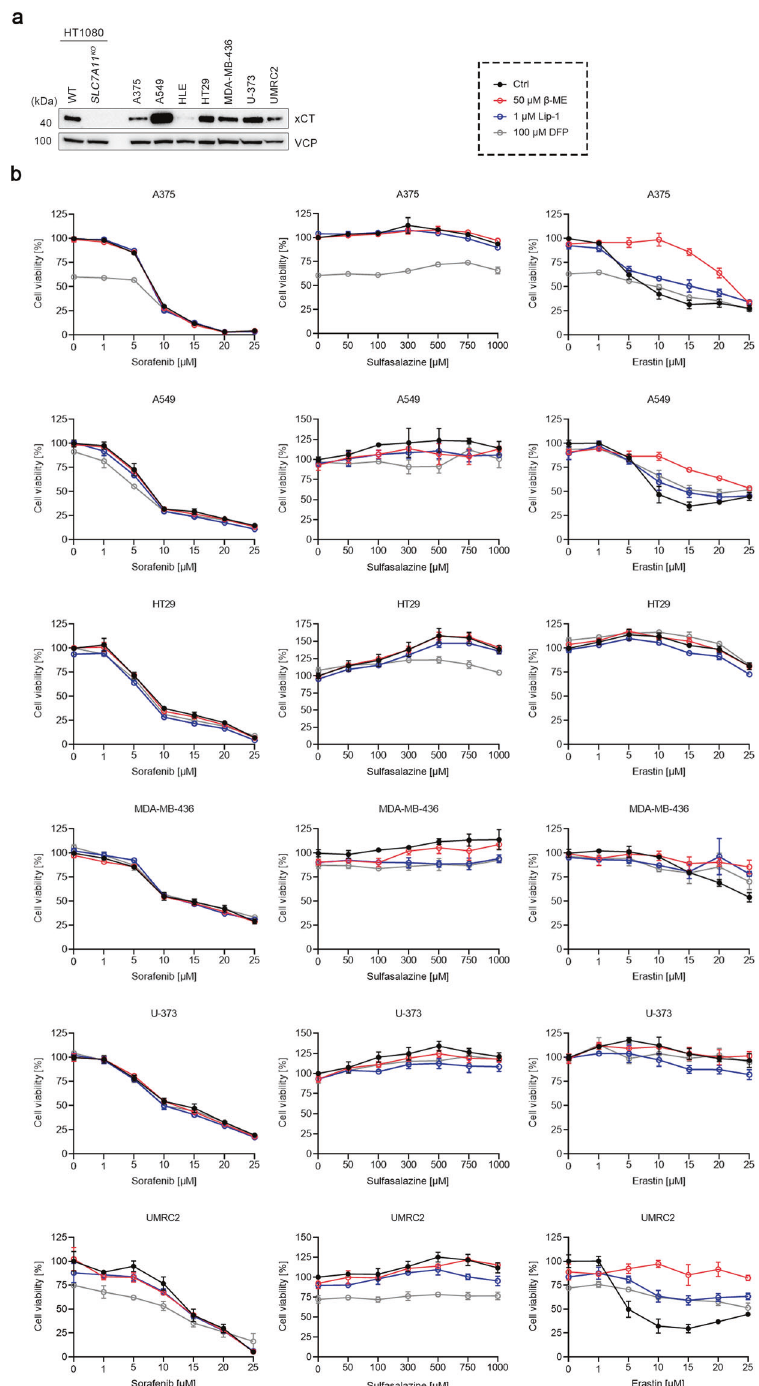
Fig. 5 Sorafenib fails to trigger ferroptosis among various cell lines with high xCT expression. a Immunoblots of xCT in WT HT1080, SLC7A11 KO HT1080, A375 melanoma, A549 lung cancer, HLE hepatoma, HT29 colon cancer, MDA-MB-436 breast cancer, U-373 glioma, and UMRC2 kidney cancer cells. VCP was used as a loading control. b Cell viability of A375, A549, HT29, MDA-MB-436, U-373, and UMRC2 cells treated with indicated concentrations of sorafenib, sulfasalazine, or erastin, in the absence or presence of 50 μ M β -ME, 1 μ M Lip-1, or 100 μ M DFP for 24 h. Data are presented as mean ± s.d. of n = 3 wells of a 96-well plate from one representative of three independent (Fig. 6b, middle panels). HepG2 cells were also sensitive to expression compared to HT1080 cells (Fig. 6a). Consistent with sulfasalazine, but only β -ME and not Lip-1 or DFP showed a the other cell lines, sorafenib-induced cell death among these protective effect. Indeed, similar results were observed when four cell lines was not prevented by the presence of β -ME, Lip-1, HepG2 cells were treated with erastin (Fig. 6b, right panels). By or DFP (Fig. 6b, left panels). Sulfasalazine failed to kill HLE and contrast, erastin-induced robust ferroptosis in HLE and HLF cells. Huh7 cells but induced robust ferroptotic cell death in HLF cells, As to Huh7 cells, they showed a similar sensitivity to erastin as as indicated by the protective effects of β -ME, Lip-1, and DFP